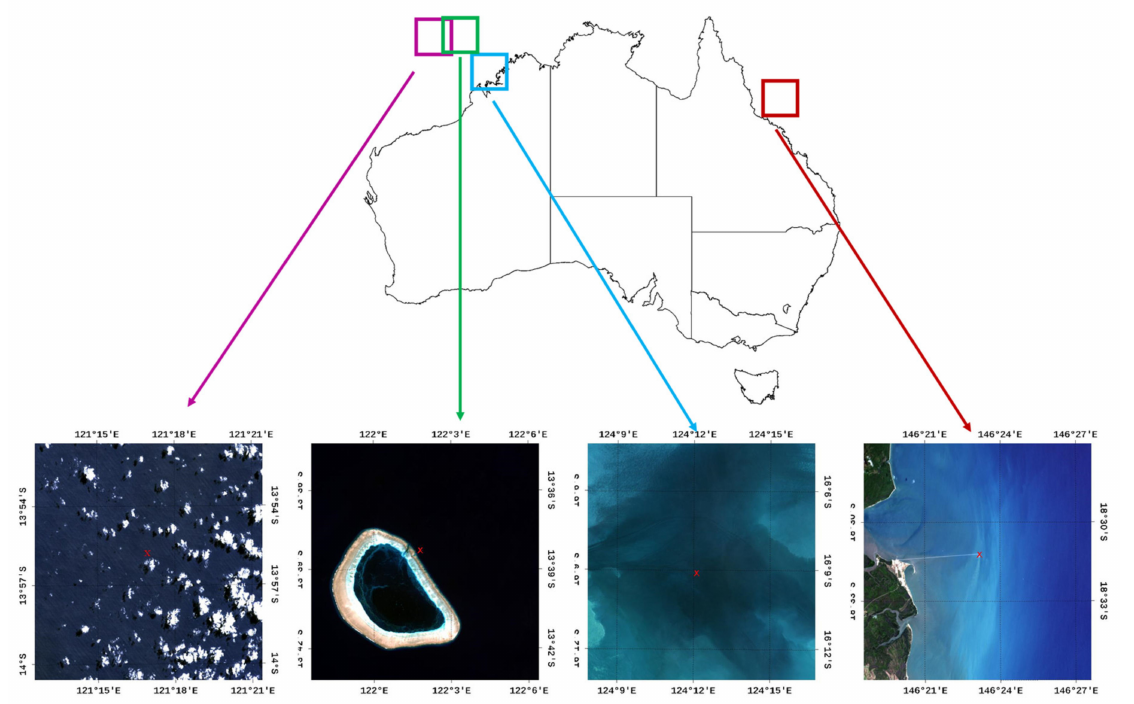
Figure 1. Four match-up site locations and examples of Landsat 8 OLI true color images (bands 4, 3 and 2), where the red box in the north east of Australia is the LJCO site, and other three boxes with different colors in the north west of Australia are the DALEC observation sites. See the text for detailed description of the four